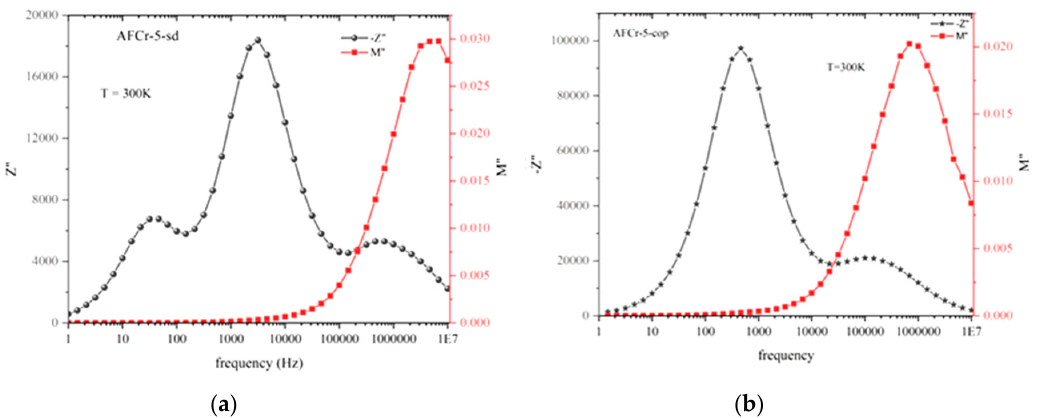
Figure 6. Frequency dependent imaginary part of impedance Z” plot of prepared samples.